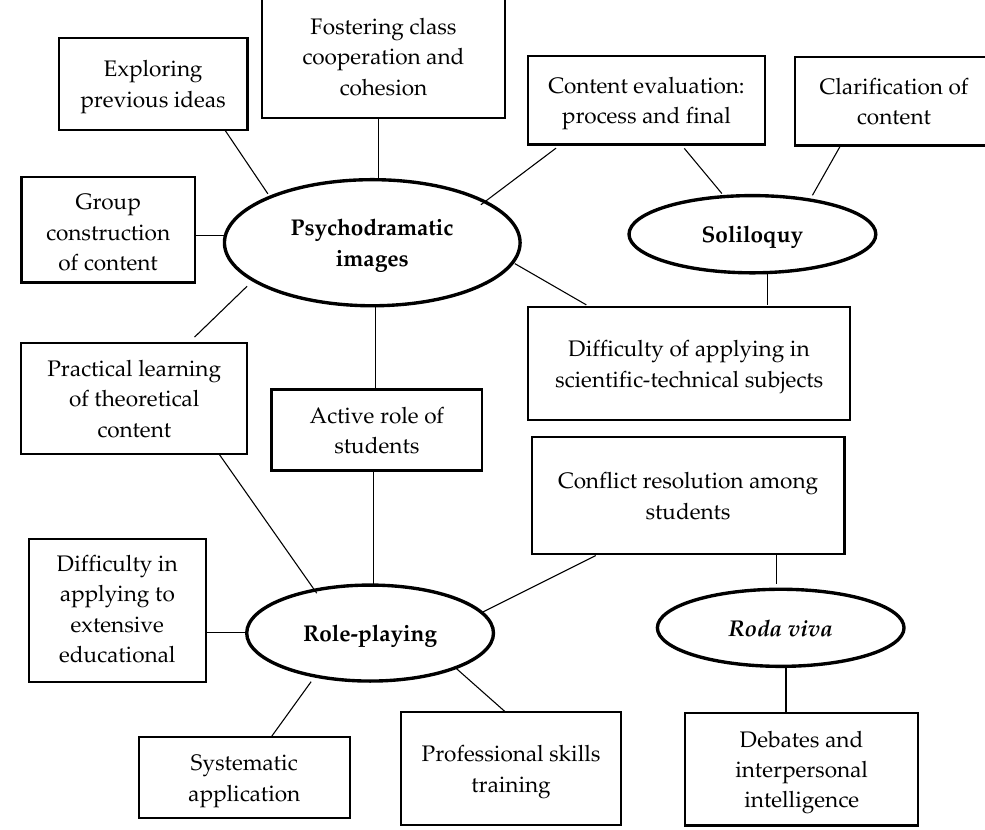
Figure 3. Perceived effectiveness of psychodramatic techniques.